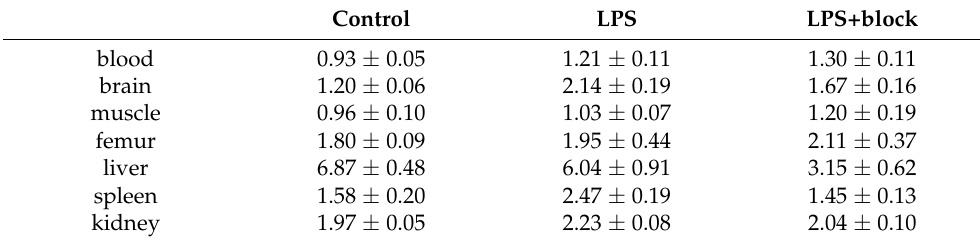
Table 2. Ex vivo biodistribution of [ 18 F] 1 in control mice, LPS mice, and LPS mice pretreated with CPPC (LPS+block).